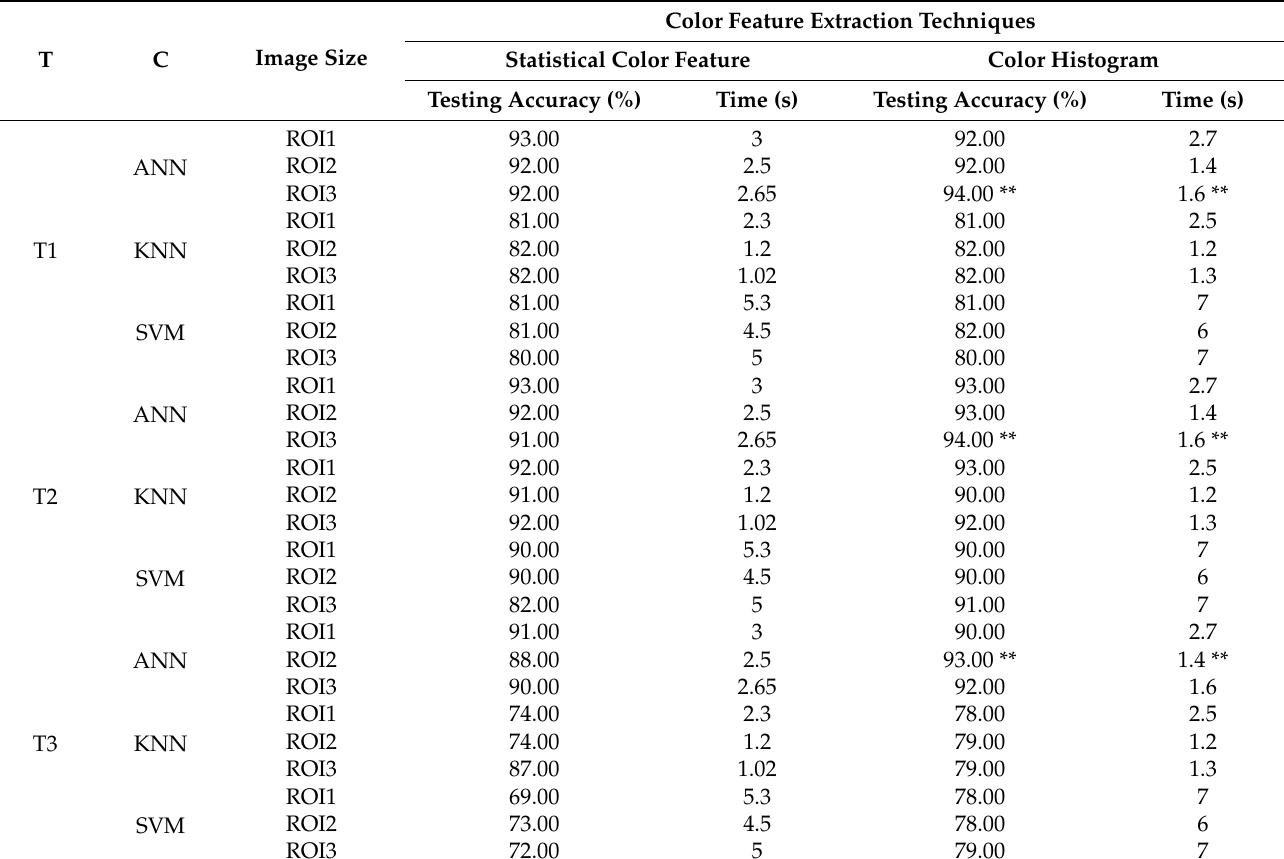
Table 6. Results of test computing FFB ripeness classification based on statistical and histogram using ANN, KNN and